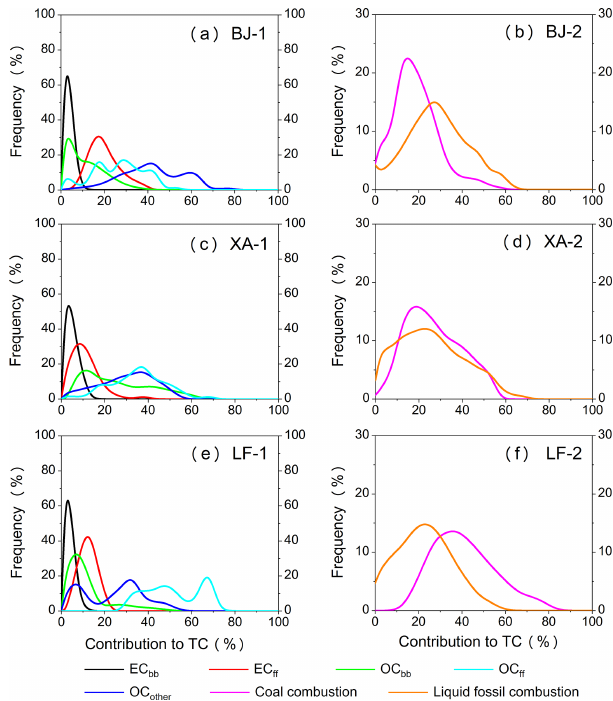
Figure 10. Latin hypercube sampling of frequency distributions of the source contributions to the total carbon (TC) from fossil, OC, and EC source categories (Table 1) for the samples collected in BJ, XA, and